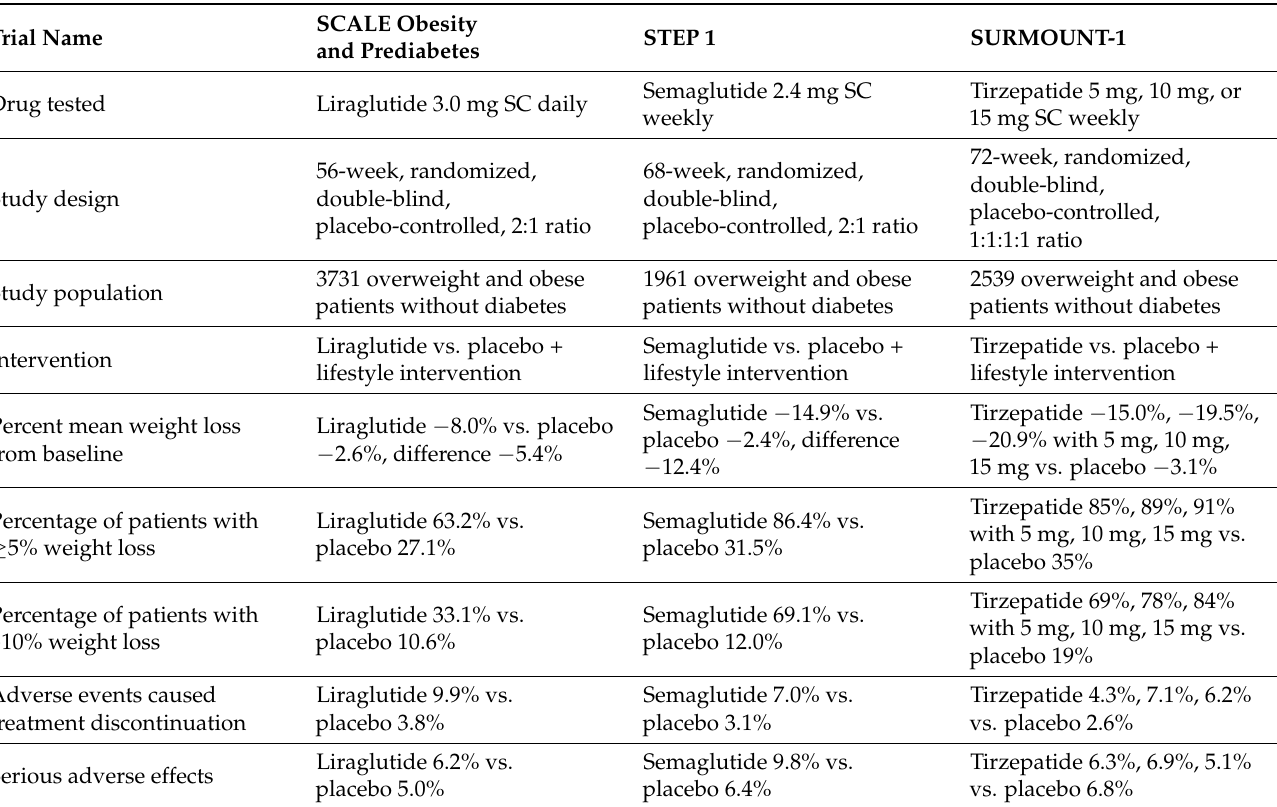
Table 1. Weight loss efficacy of liraglutide, semaglutide, and tirzepatie in overweight and obese patients without